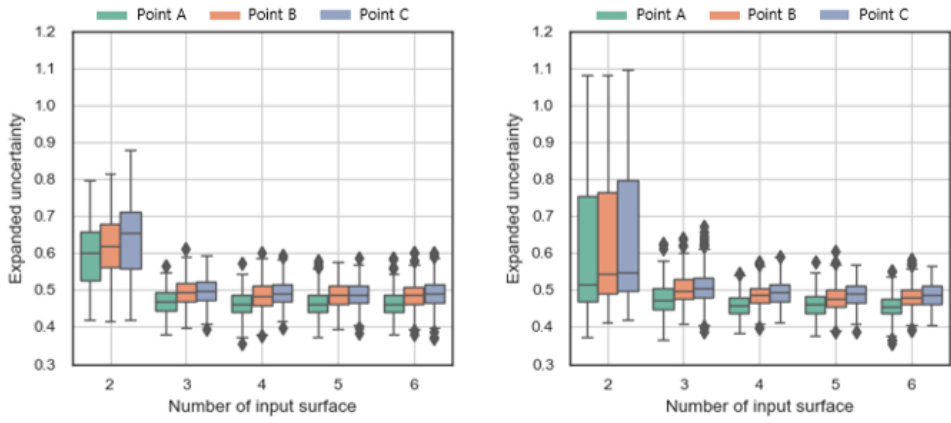
Figure 13. Expanded uncertainty: winter ( left ), summer ( right ).